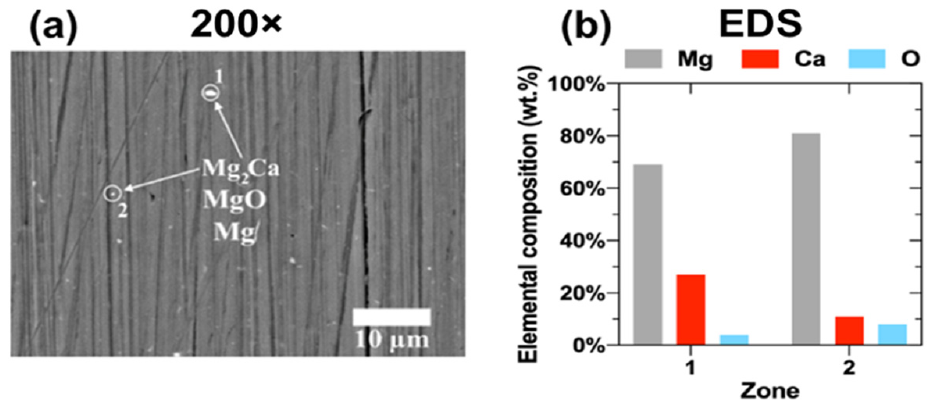
Figure 1. ( a ) SEM image (2000 × ) of Mg–Ca0.3 reference sample and ( b ) EDS analysis of sites labeled on the SEM image and the suggested compounds.